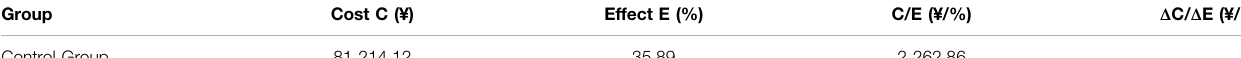
TABLE 5 | Comparison of costs and effects of clinical pharmacist intervention between control and intervention groups.